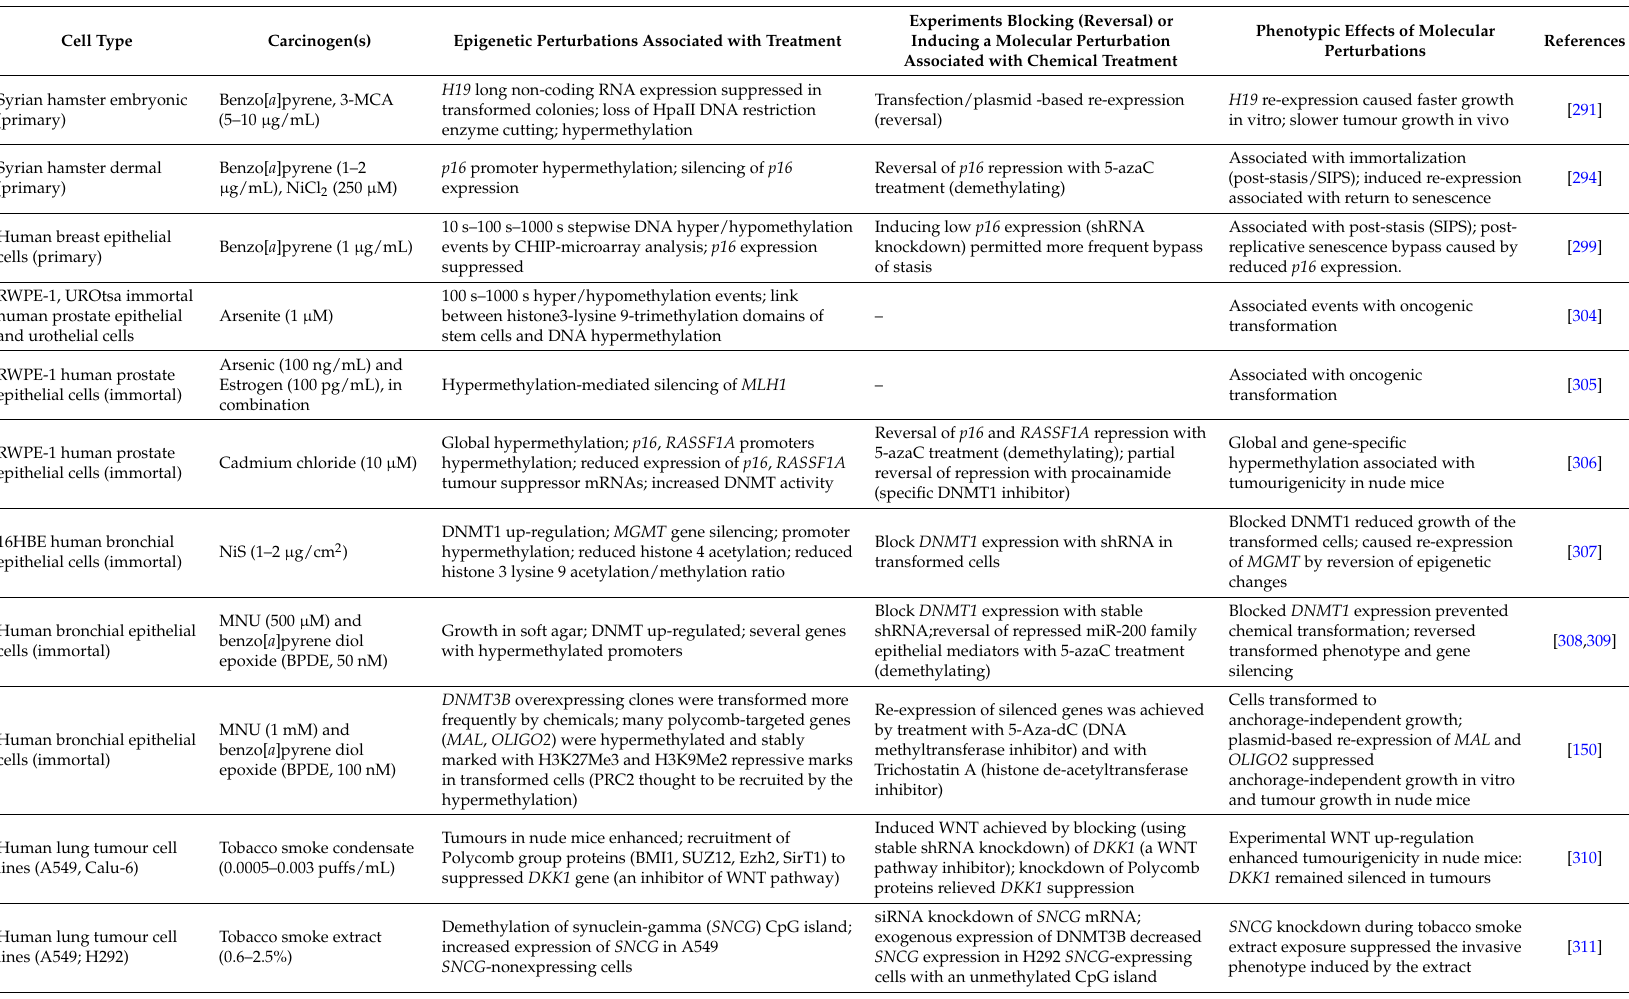
Table 5. Selected in vitro experimental studies describing causal, toxin-induced epigenetic pathways leading to cancer-like phenotypes. Experiments in human and rodent in vitro cell transformation systems establishing mechanistic links: (including experiments that “show it; block it; induce it”). Rows are arranged by cell